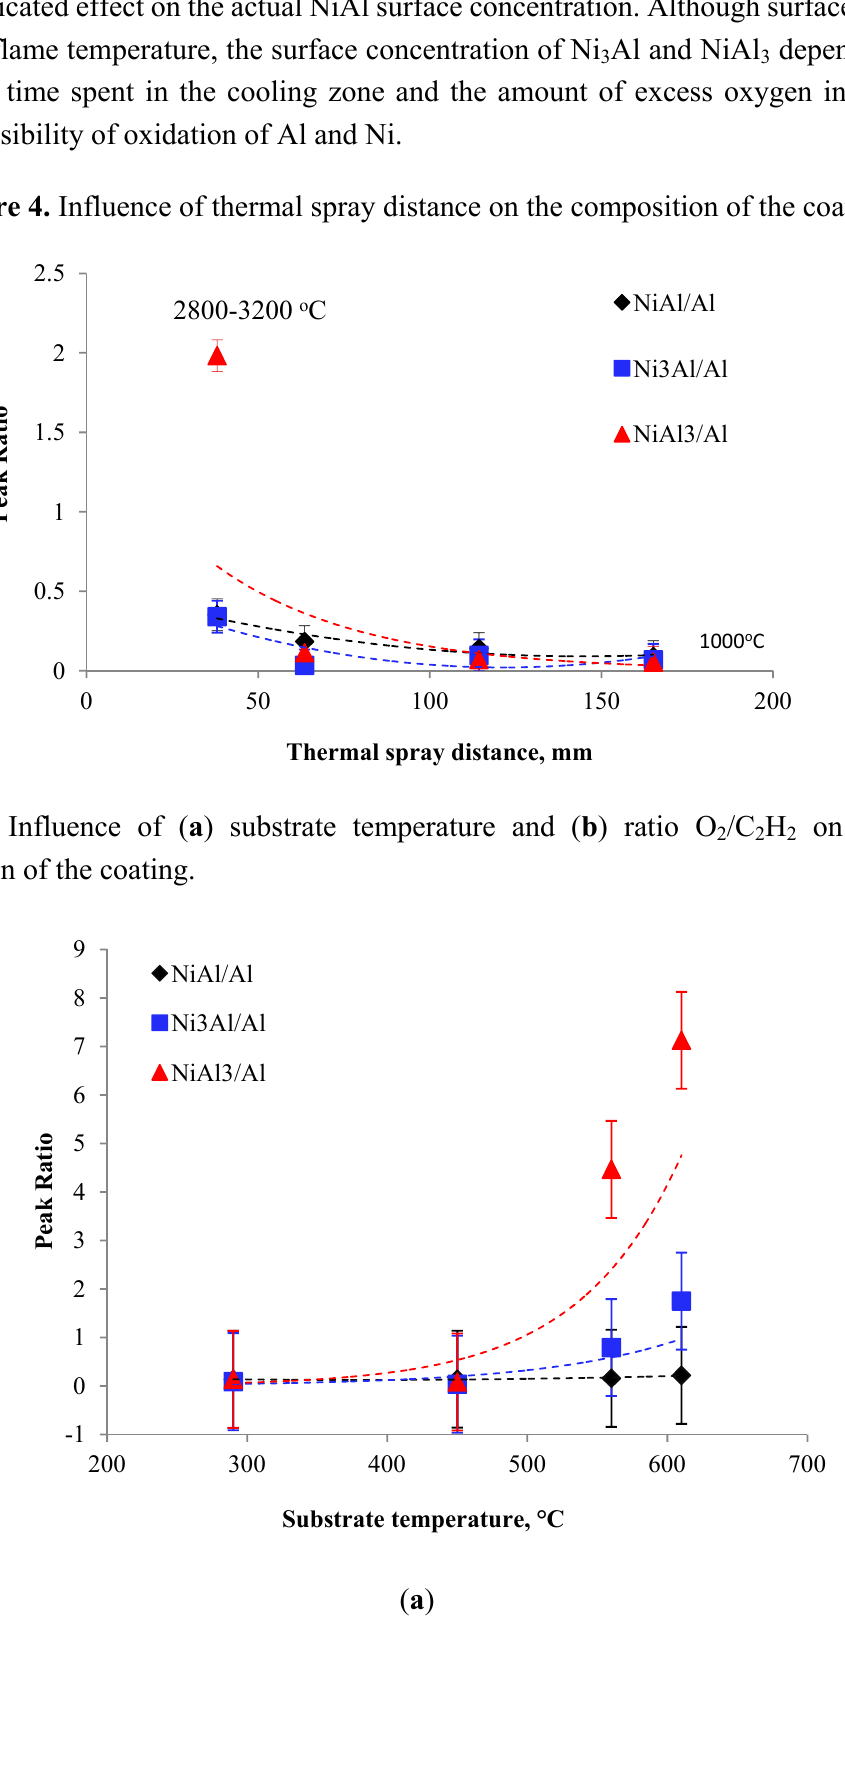
Figure 4. Influence of thermal spray distance on the composition of the coating.